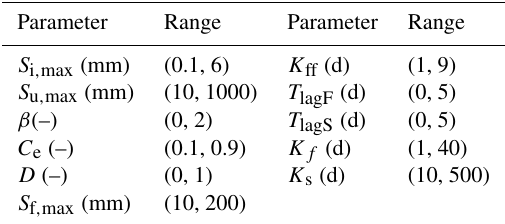
Table 3. Parameter ranges of the FLEX model. Parameter Range